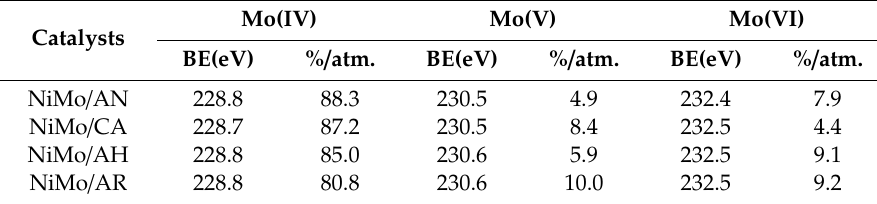
Table 2. Fractions of Mo species in the sulfided catalysts by XPS analysis.